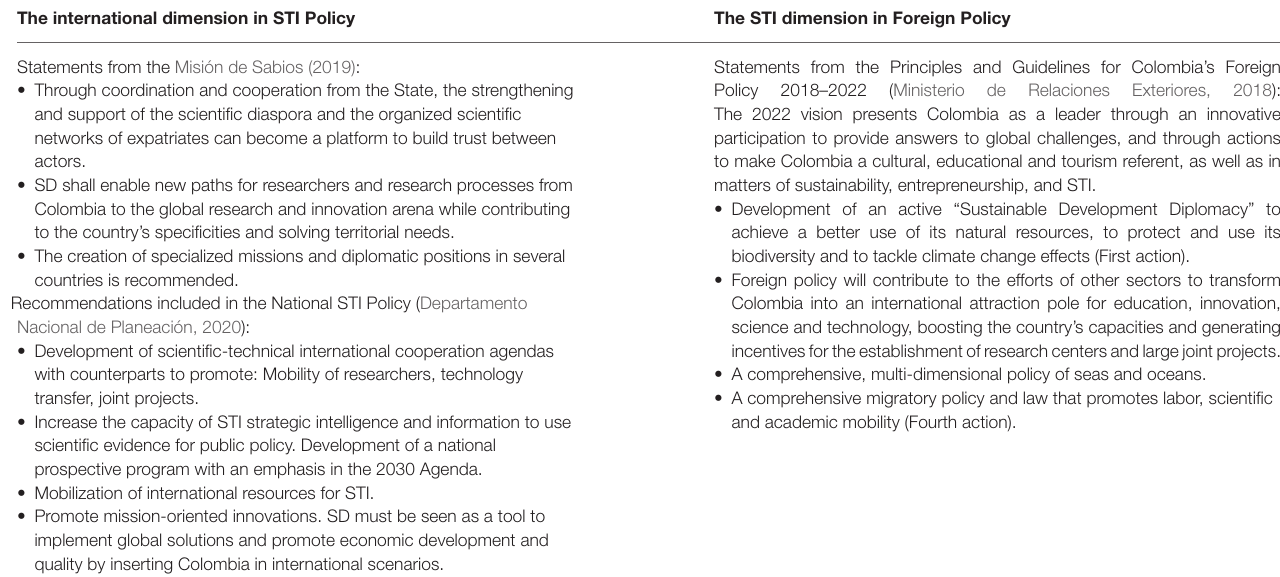
TABLE 2 | The international dimension in STI Policy and the STI dimension in Foreign Policy in Colombia. The international dimension in STI Policy The STI dimension in Foreign